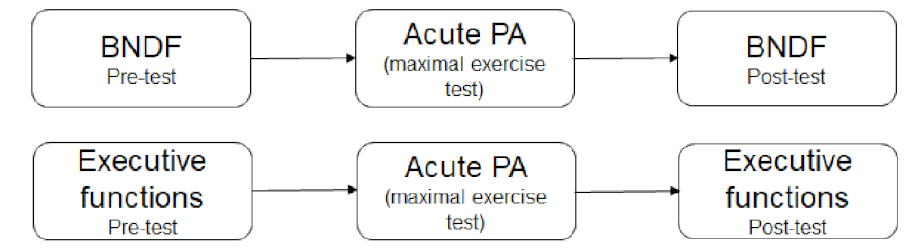
Figure 2. The effect of acute PA on (1) BDNF levels and (2) executive